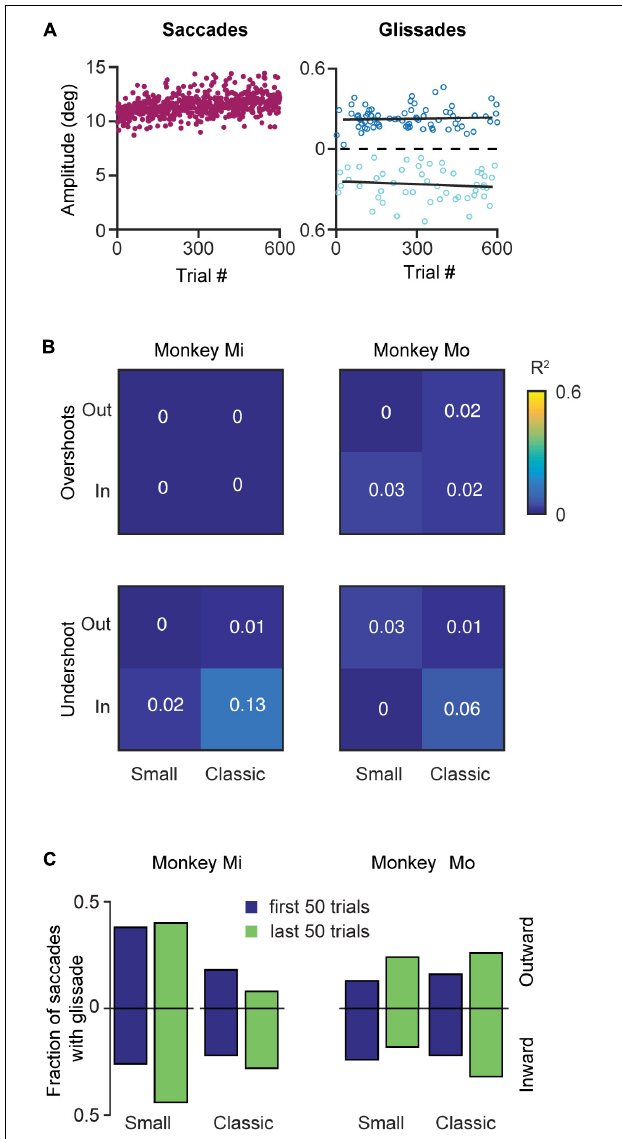
FIGURE 9 | Effects of saccadic adaptation on glissades. (A) Example of a classical outward saccadic adaptation experiment from monkey Mo. Left panel, purple dots correspond to the saccade amplitudes gradually increasing over time. Right panel, dark blue dots display amplitude of the glissadic overshoots and light blue dots display amplitudes of the glissadic undershoots. Black lines represent a linear fit. (B) Top panels display R 2 of linear fits of glissadic overshoot amplitudes during inward and outward saccadic adaptation with a classical and small adaptation step. The bottom panels display the same for undershoots. Monkey Mi did not make any glissadic overshoots. Labels “Mi” and “Mo” denote each of the two monkeys. (C) Fraction of saccades with overshooting and undershooting glissades pooled in the first and last 50 trials of the adaptation. Upward bars represent outward saccadic adaptation experiment and downward bars represent inward saccadic adaptation experiments for p -values see Supplementary Table 7